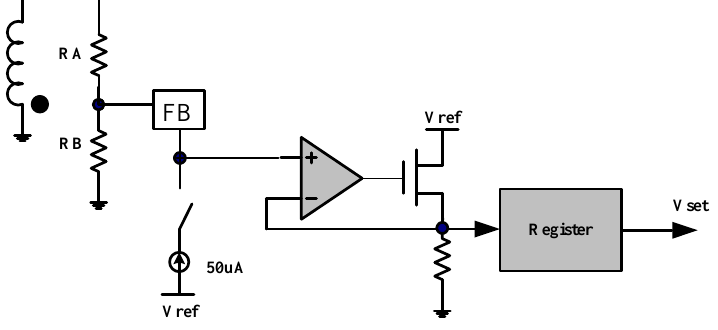
Figure 11. Circuit for adjusting the frequency swapping range.